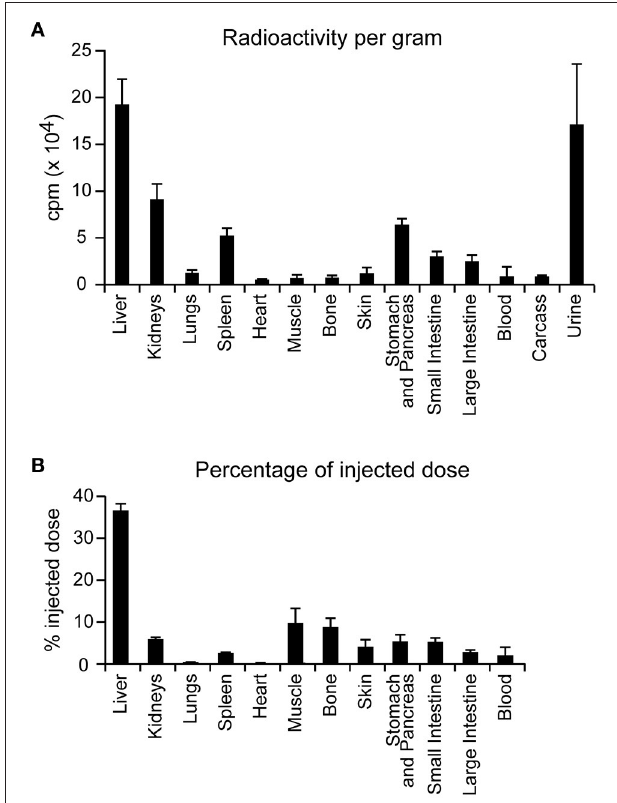
FIGURE 7 | Biodistribution of I 125 -radiolabeled TAT-RasGAP 317 − 326 in BALB/c mice. Five BALB/c mice were injected with 1.6 mg/kg I 125 -radiolabeled TAT-RasGAP 317 − 326 peptide. Six hours after, mice were sacrificed and radioactivity of each organ mentioned in the figure was recorded in counts per minute (cpm). (A) Radioactivity of each organ normalized per gram of organ. Carcass was all the remaining mouse material after organ removal. Error bars are displayed in 95 percent confidence interval. (B) Percentage of the injected radioactive dose recorded in each organ. Error bars are displayed in 95 percent confidence interval.